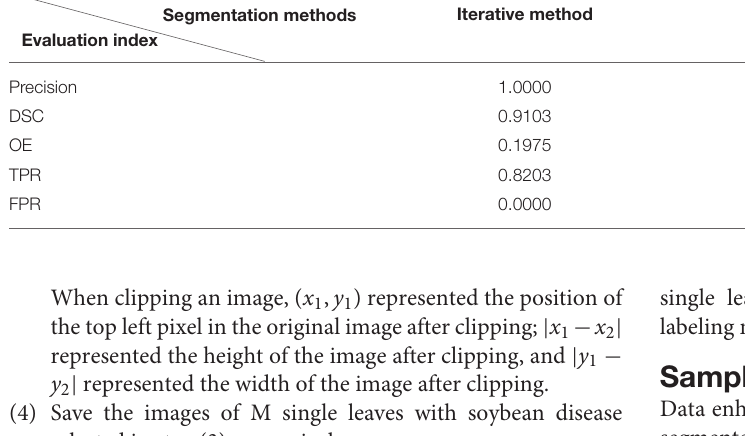
TABLE 1 | Evaluation of segmentation